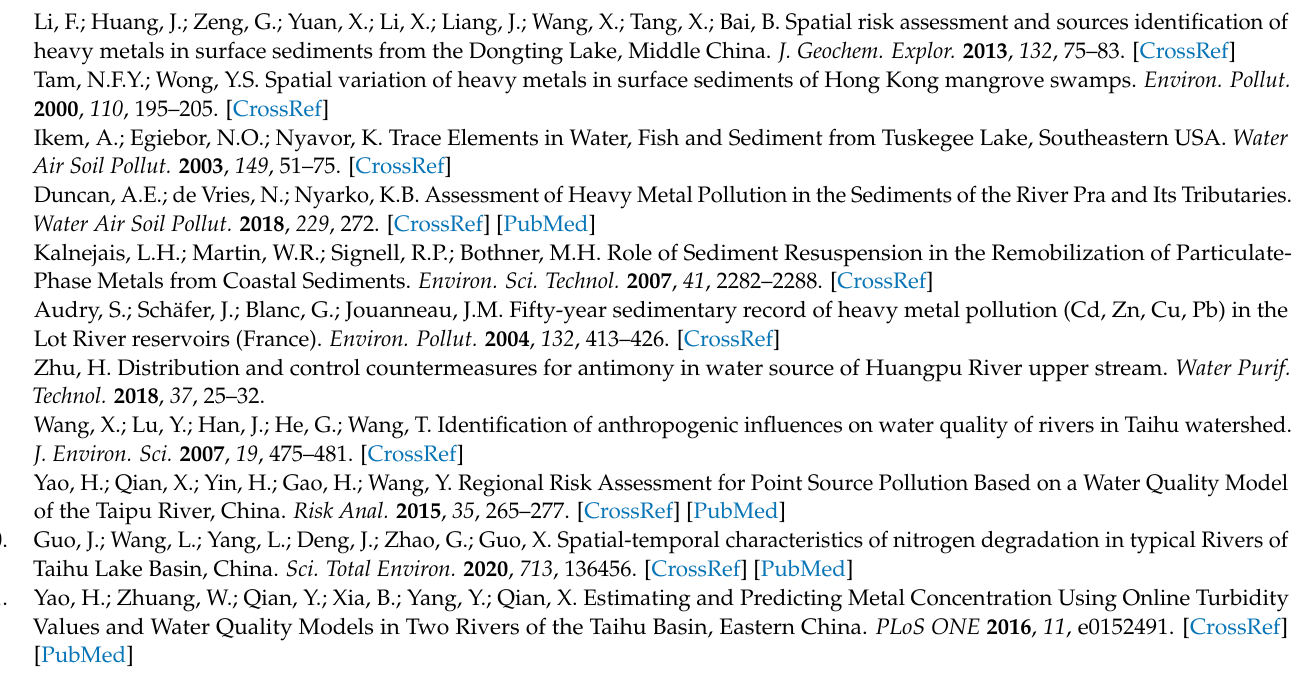
Table S6: Correlation analysis of PTEs and physicochemical properties in surface sediments of the Taipu River; Figure S1: Percentage of different pollution grades of PTEs in the geoaccumulation index ( I geo ) of 25 surface sediments in background values of three provinces (Zhejiang, Shanghai and Jiangsu); Figure S2: Percentage of different pollution grades of PTEs in the enrichment factor ( EF ) of 25 surface sediments in background values of three provinces (Zhejiang, Shanghai, and